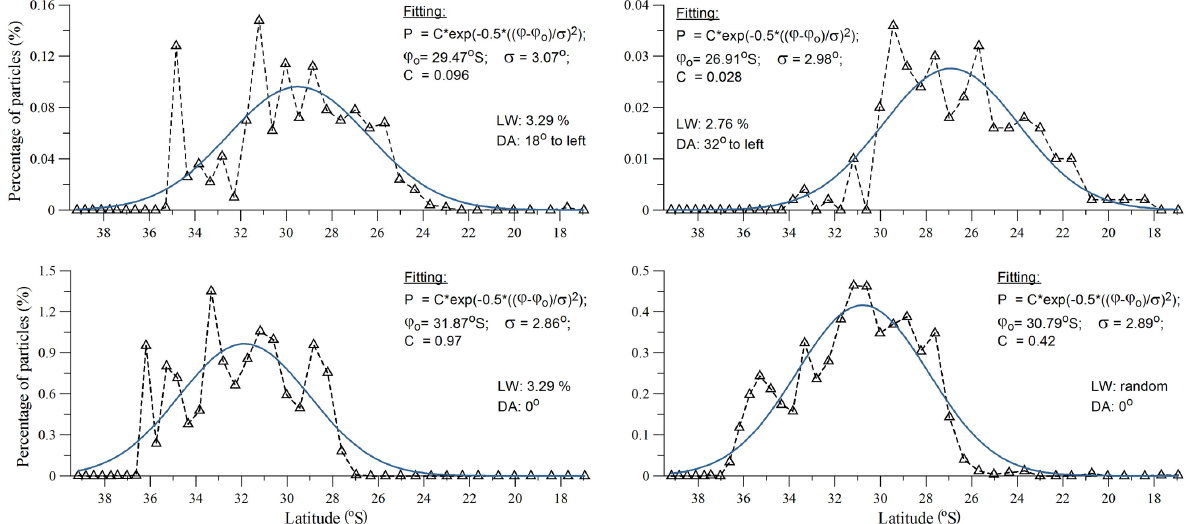
Figure 7. Percentages of particles satisfying distance and temperature criterion with the score S > 0 . 01 (LW: leeway factor; DA: drift angle).